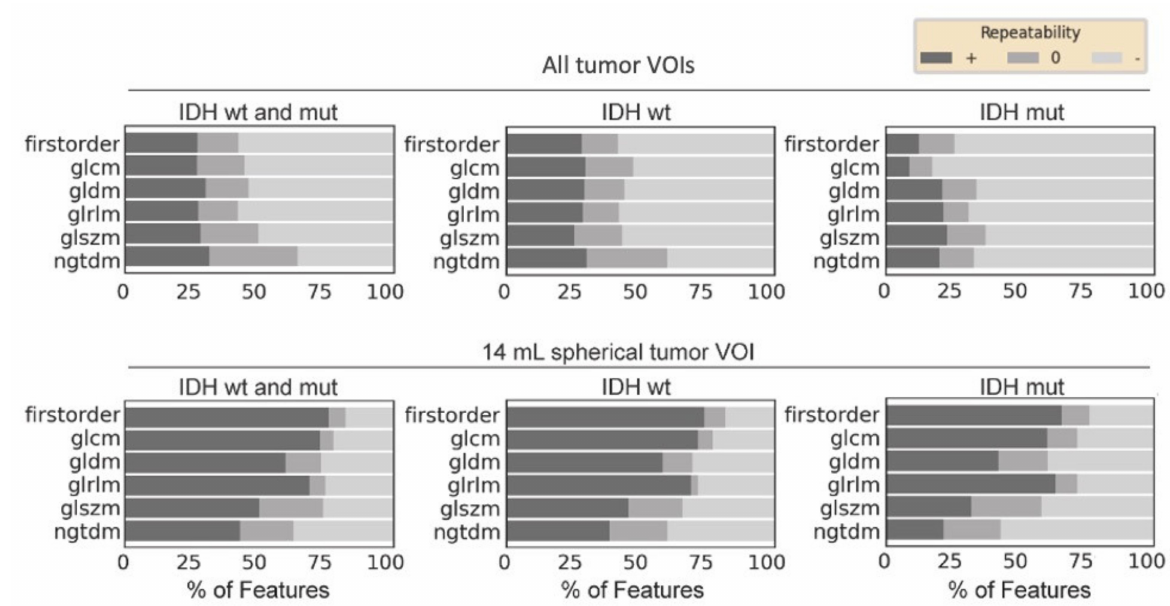
Figure 7. Influence of the isocitrate dehydrogenase (IDH) genotype on feature repeatability. Feature repeatability of individual feature groups in percentage shown for IDH-wildtype and IDH-mutant gliomas. Features were calculated for every sample on the complete tumor region (upper panels), or for the 14 mL spherical tumor volume-of-interest (VOI) representing the average tumor volume in our study (lower panels). Features were considered repeatable if the lower and upper limits of the intraclass correlation coefficient 95% confidence interval were in the range of 0.91 to 1.00 (+, dark gray), not repeatable if between 0.01 and 0.90 ( − , light gray), and moderately repeatable if the upper limit was between 0.91 and 1.00 and the lower limit was in the range of 0.75 to 1.00 (0, medium gray). glcm = gray level co-occurrence matrix; gldm = gray level dependence matrix; glrlm: gray level run length matrix; glszm = gray level size zone matrix; IDH = isocitrate dehydrogenase; MUT = mutant; ngtdm = neighboring gray tone difference matrix; VOI = volume-of-interest, WT =